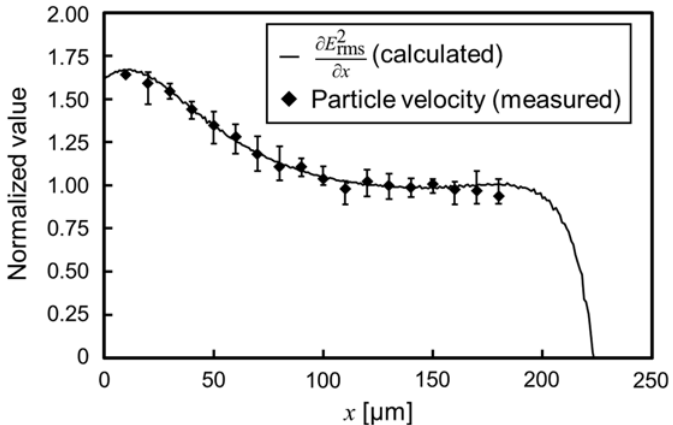
Figure 8. Distribution of the calculated ∂ E 2 rms / ∂ x and measured particle velocity. The applied voltage and frequency were 40 V p-p and 1 MHz, respectively. The error bar of the plot shows the maximum and minimum velocity in the measurement.